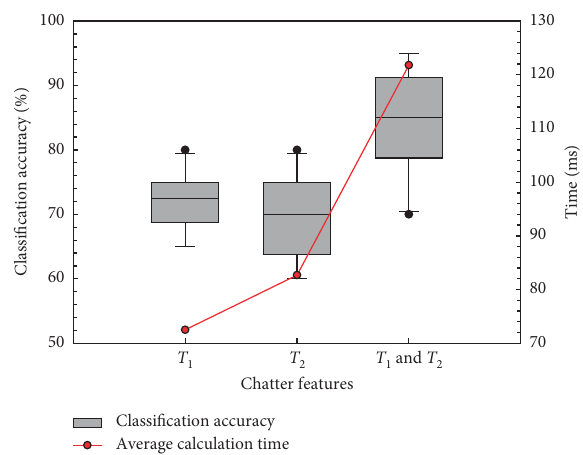
Figure 12: Classification results of T